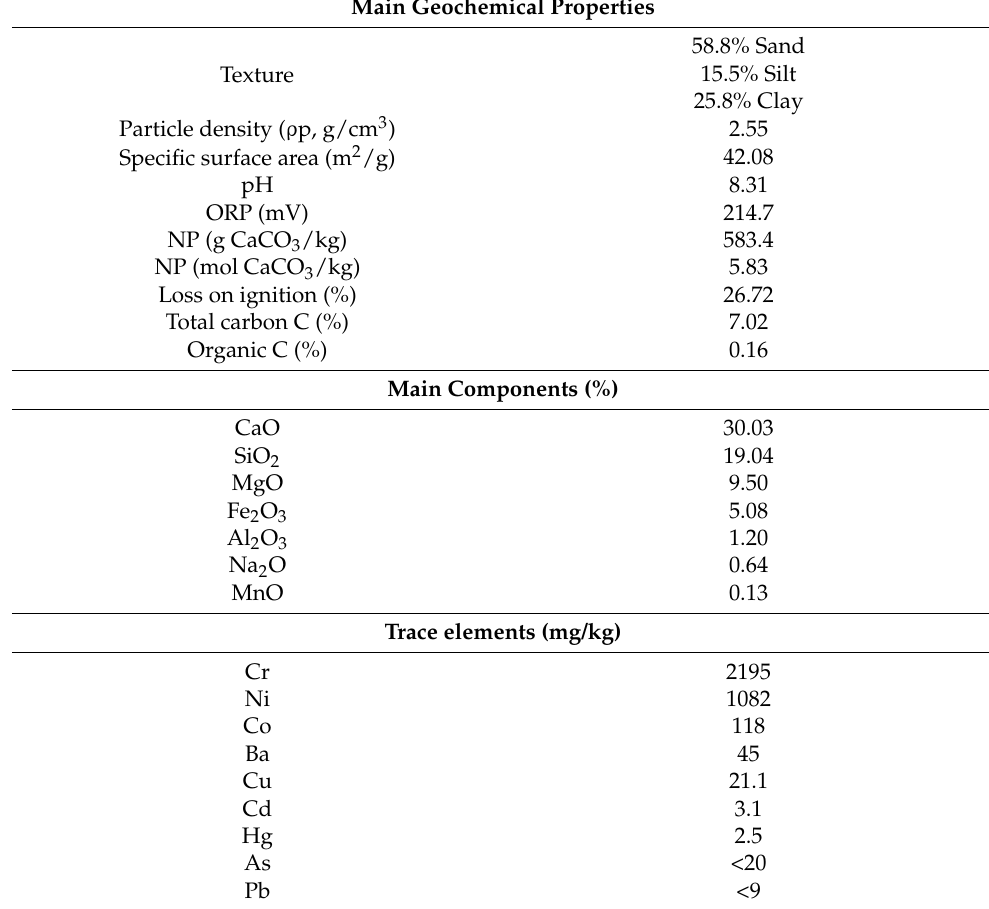
Table 1. Properties and characteristics of the soil used in the column